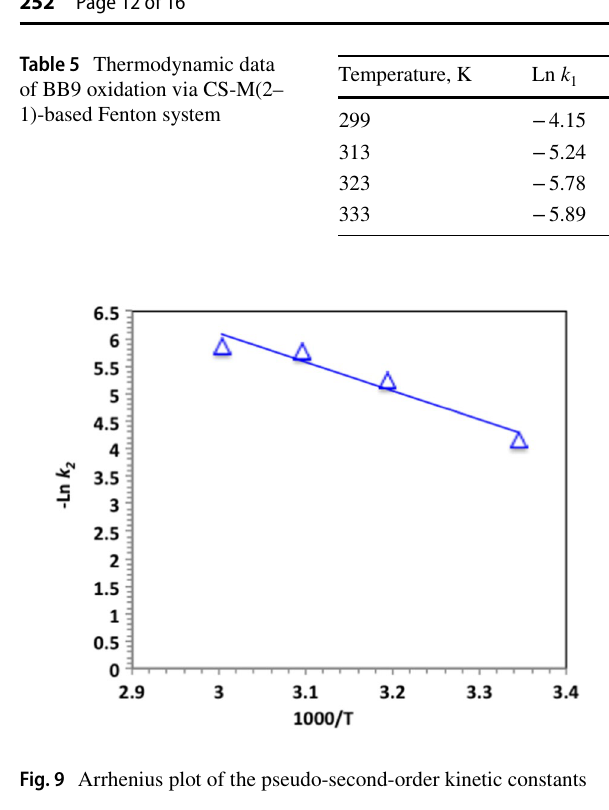
Fig. 9 Arrhenius plot of the pseudo-second-order kinetic